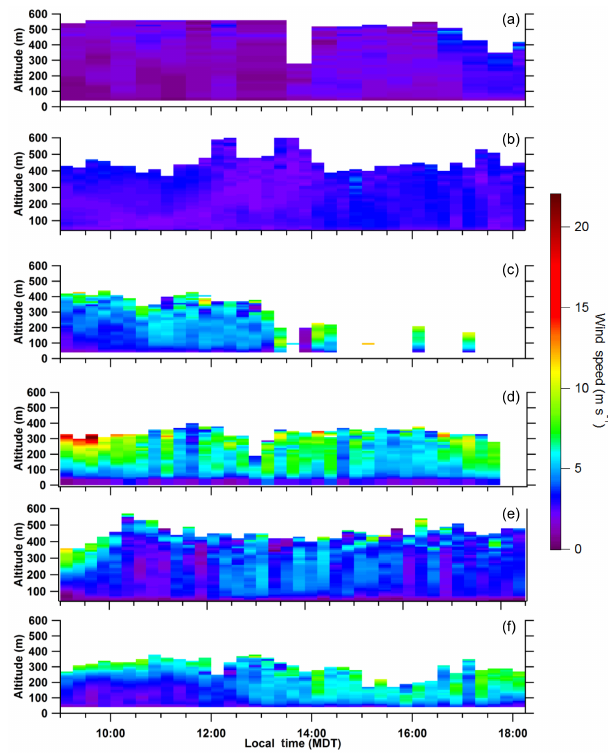
Figure 3. Vertical profiles of wind direction: 23 August (a) , 3 September (b) , 4 September (c) , 5 September (d) , 6 September (e) , and 7 September (f)